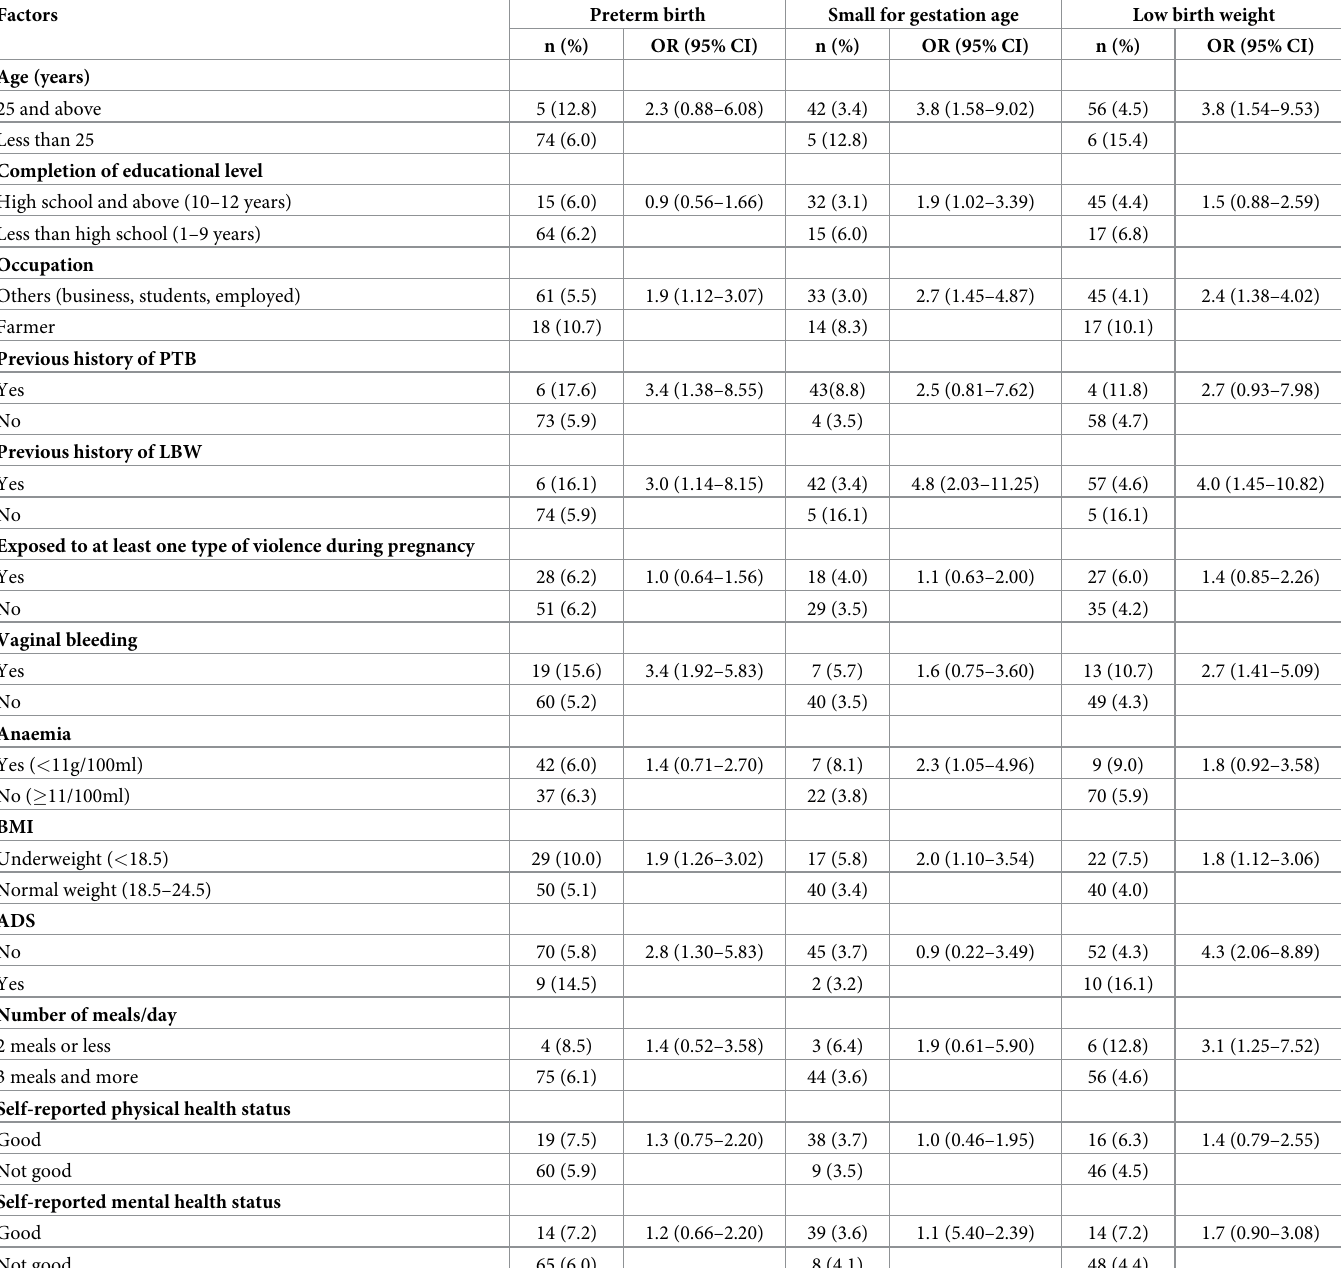
Table 2. Bivariate analyses between potential confounders and the outcomes under